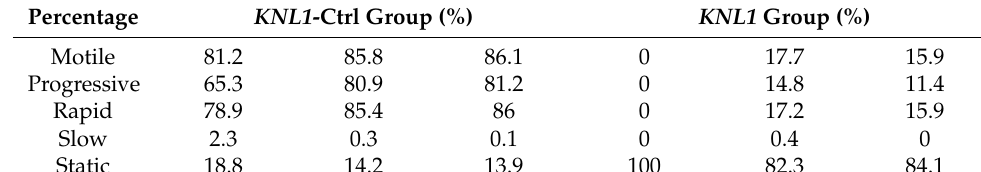
Table 3. The CASA percentage data of KNL1 -Ctrl and KNL1 -60 µg Group mice.